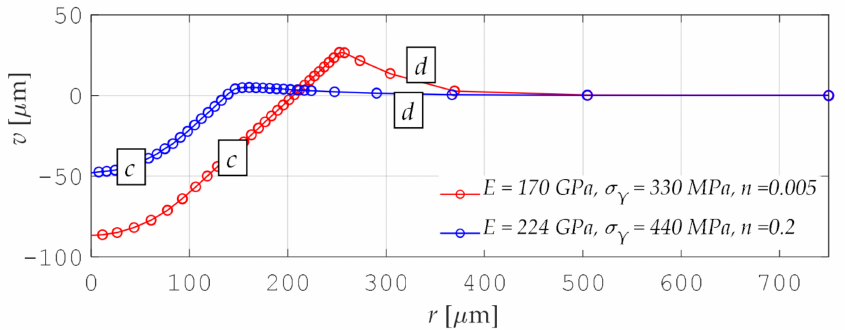
Figure 7. Example diagrams of imprint profiles and their approximation functions (the letters c and d denote separate branches of one diagram).